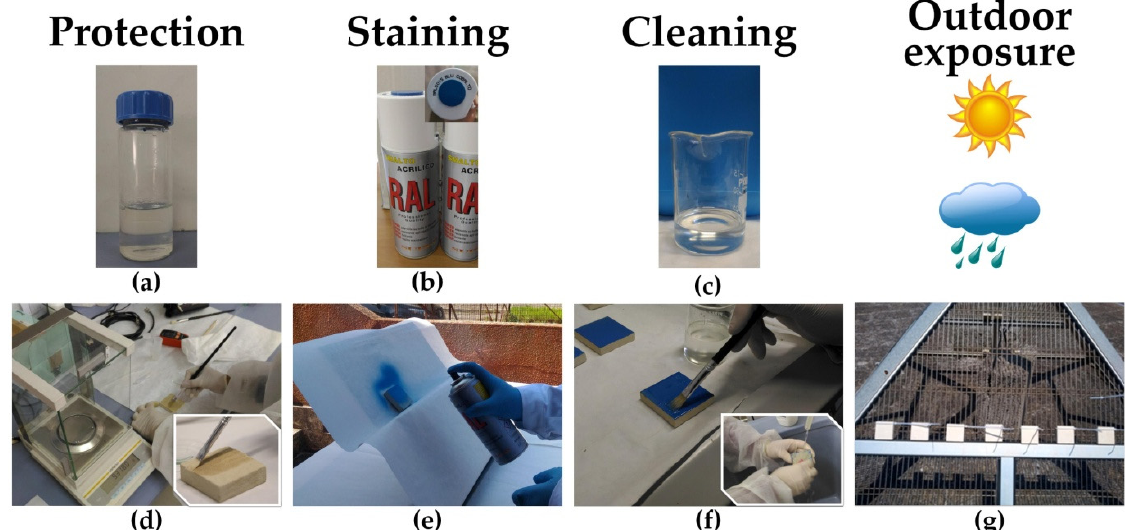
Figure 1. Materials and treatments: ( a ) Liquid fluorine-based polymer for stone protection; ( b ) Spray cans of acrylic paint; ( c ) Chemical remover for graffiti cleaning; ( d ) Set-up for the application of the coating and detail of brushing on a specimen of Lecce stone; ( e ) Staining by the blue-colored paint; ( f ) Application of the chemical remover and subsequent rinsing by running tap water and a sponge; ( g ) Stone specimens during the outdoor exposure.